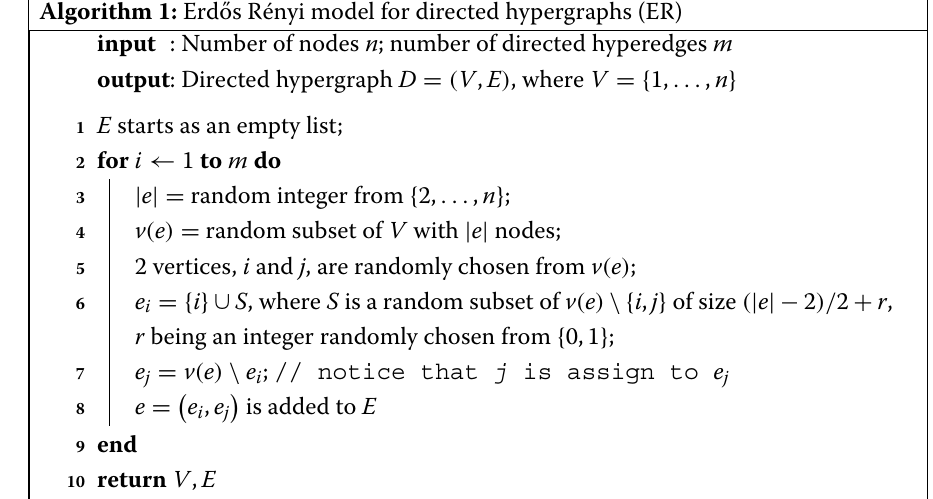
Algorithm 1: Erd˝os Rényi model for directed hypergraphs